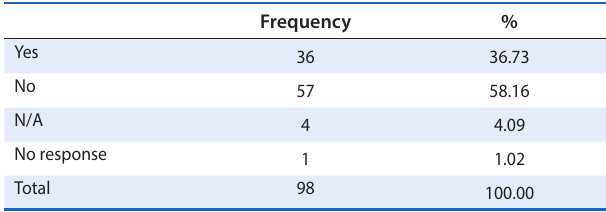
Table 4: Usage of contraceptives at first sexual encounter